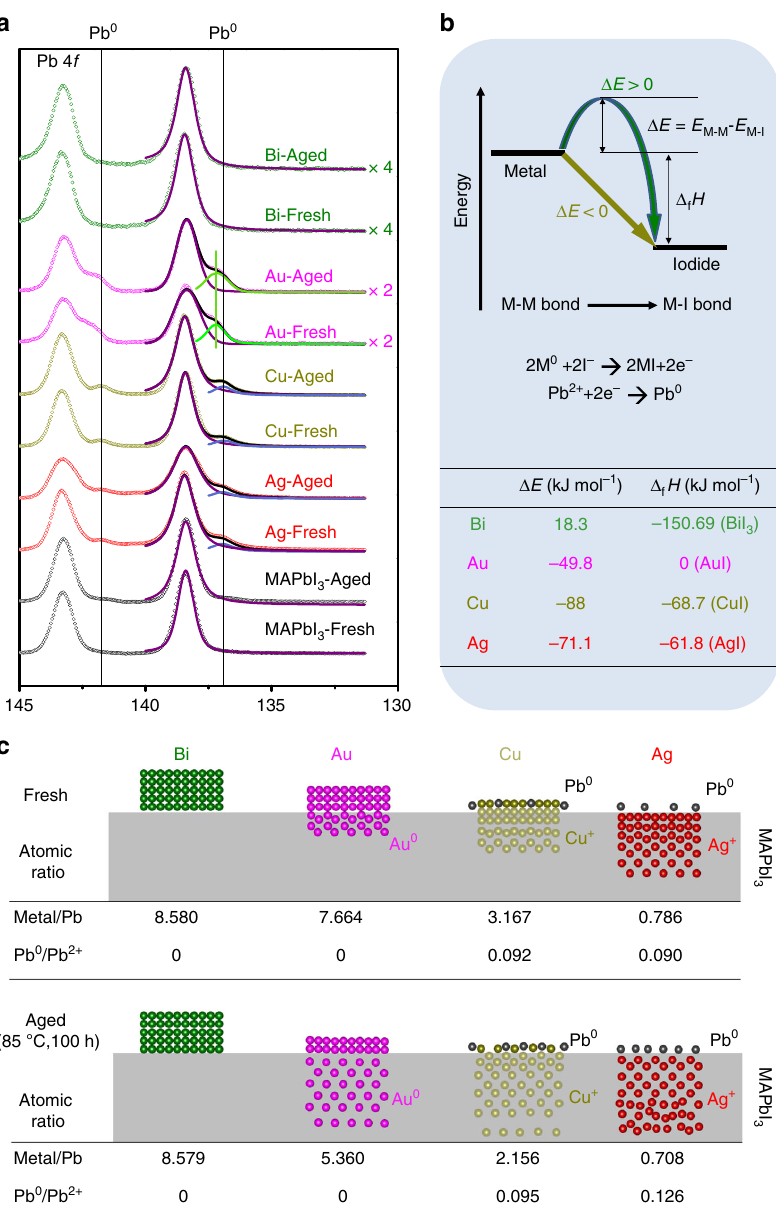
Fig. 1 Chemical reaction of metal-perovskite. a XPS spectra of Pb 4 f for fresh and aged samples, including MAPbI 3 /Bi, MAPbI 3 /Au, MAPbI 3 /Cu, MAPbI 3 / Ag, and only MAPbI 3 (aging conditions: in the dark, in N 2 atmosphere, 85 °C, 100 h). b Schematic diagram and the corrosion reaction equations. The standard enthalpy of formation ( Δ f H , 298.15 K) and the reaction barrier ( Δ E ) are also listed. c Schematic diagram of metal diffusion into the perovskite and the atomic ratios at the upper surface. Source data are provided as a Source Data fi